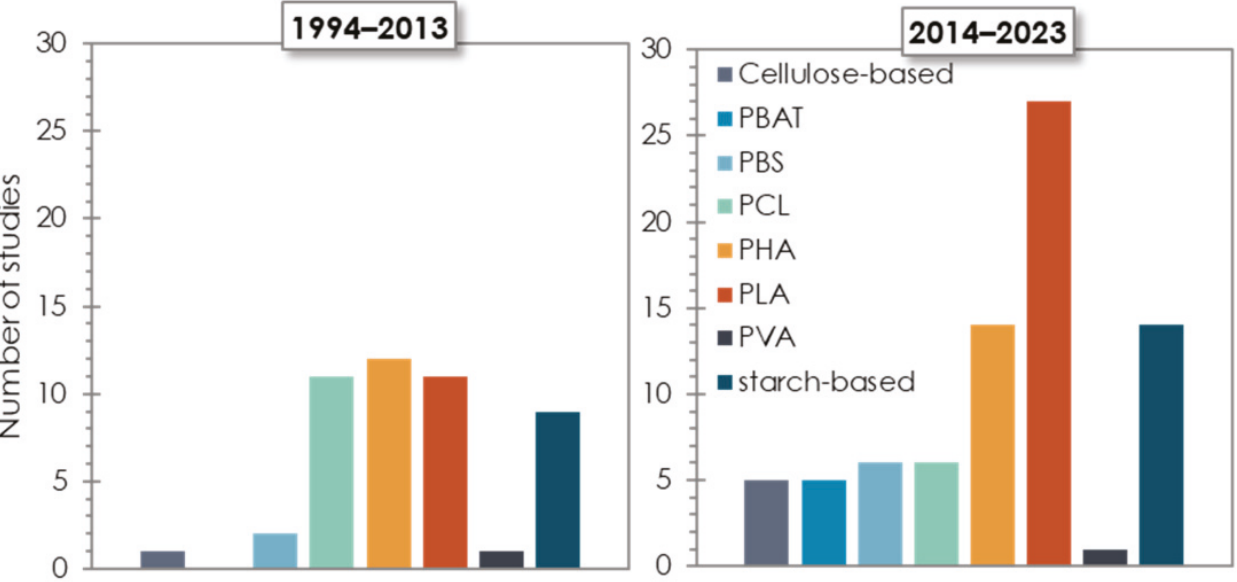
Figure 5. Number of studies on the different biopolymers over the last two